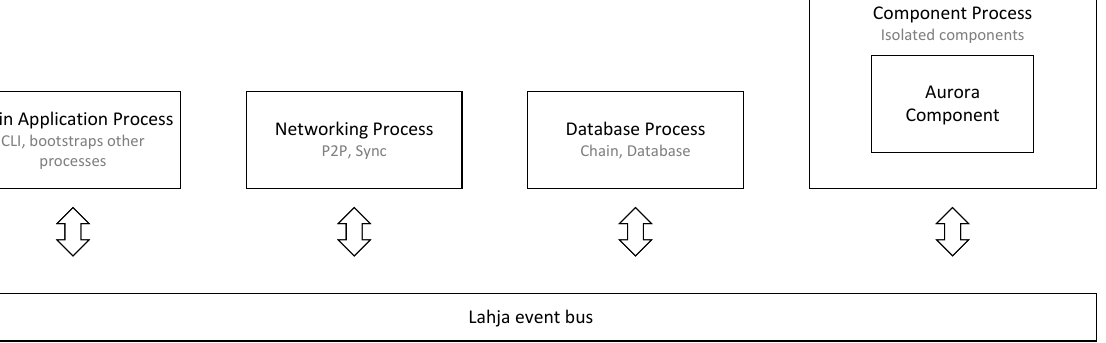
Figure 3. High-level representation of communication between Trinity components. The Main Application Process starts the Networking Process and the Database Process. The Networking Process handles peer-to-peer communication. The Database Process provides operations related to the chain and uses LevelDB by default. The Aurora Component enables the use of Feature 1 and Feature 2 on the